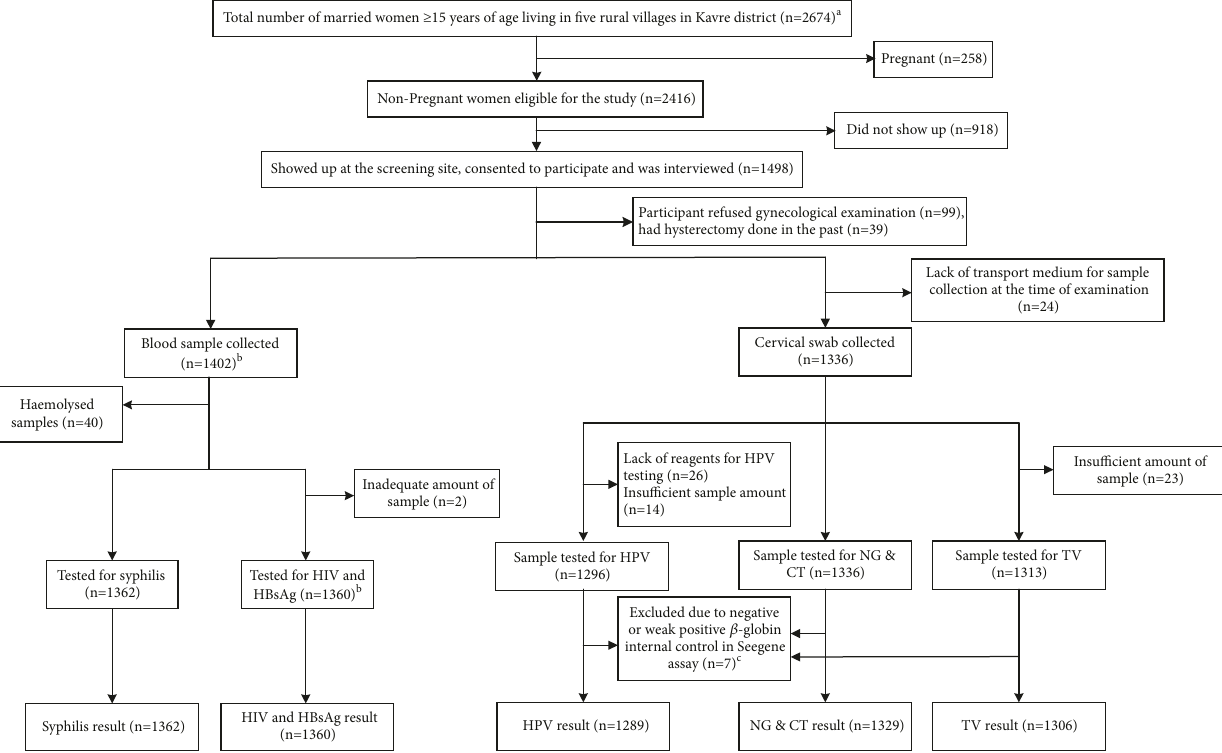
Figure 1: Flow chart showing selection of study participants, sample collection, and analyses. a Villages: Bolde Fediche,Thulopersel, Pokhari- Naranyanthan, Saramthali, and Sarasyunkharka. b Refused blood sample collection (n=96). c Samples with negative or weakly positive 𝛽 - globin gene internal control for human DNA in the Seegene Anyplex (cid:3) II HPV28 real-time PCR were considered to have inadequate amount of sample or contained inhibitors and were therefore excluded from further analyses; CT, Chlamydia trachomatis ; NG, Neisseria gonorrhoeae ; HPV, human papillomavirus; TV, Trichomonas vaginalis